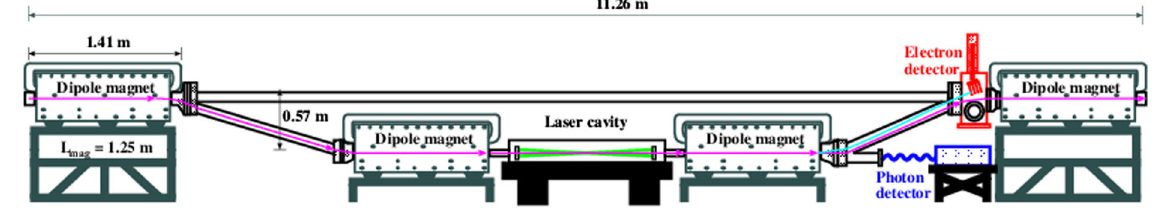
FIG. 1. Schematic diagram of the JLab Hall C Compton polarimeter. Four identical dipole magnets form a magnetic chicane that displaces the 1.16-GeV electron beam vertically downward by 0.57 m. An external low-gain Fabry-Pérot laser cavity provides a high- intensity (about 1.7 kW) beam of circularly polarized green (532-nm) photons. The laser light is focused at the interaction region ∼ 90 μ m), and it is larger than the electron-beam envelope ( σ ∼ 40 μ m). The photon detector was not used for these results. ( σ waist x = y